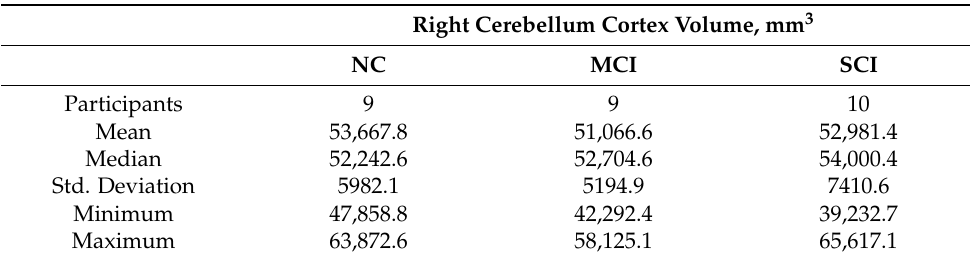
tion (NC), mild cognitive impairment (MCI), and moderate/severe cognitive impairment (SCI).